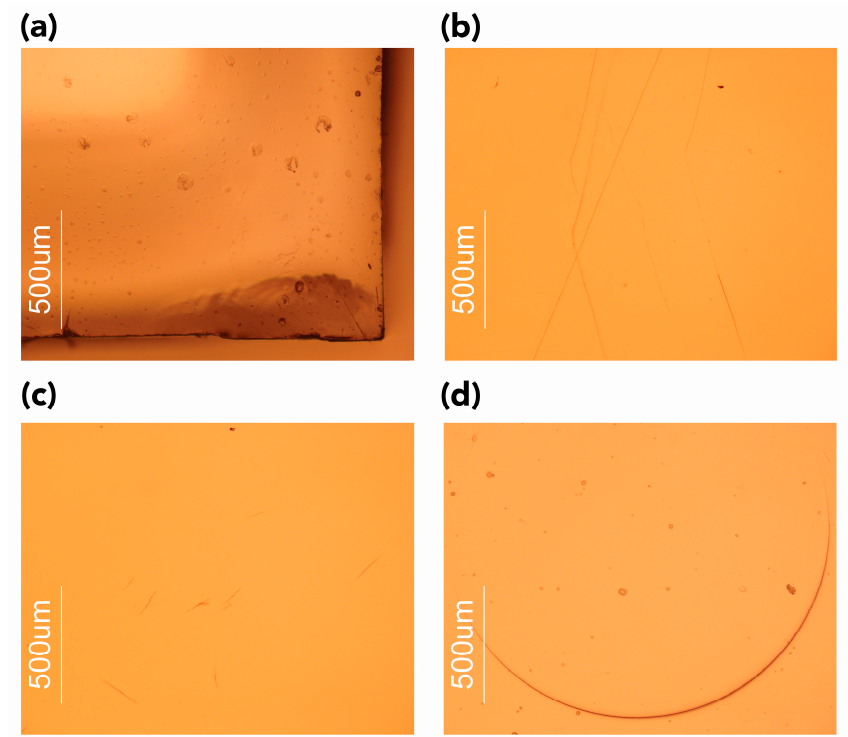
Figure 4. Representative microphotographs acquired in reflected light in brightfield showing ( a ) the presence of abrasion and ( b ) cracks, ( c ) free and impinged bubbles in the sample’s bulk, and ( d ) indentation mark left by the tip of the pressure clamp used to ensure contact between the exposed test sample and the crystal during ATR-FTIR spectroscopy. Magnification ×50.